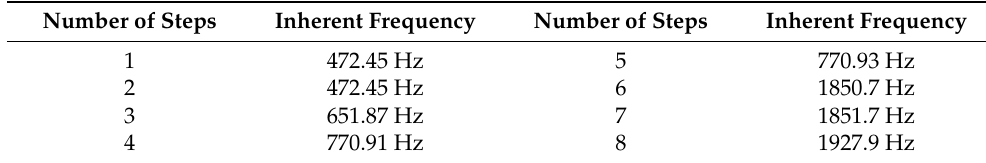
Table 6. The first 8 order natural frequencies of impeller rotor in case C.